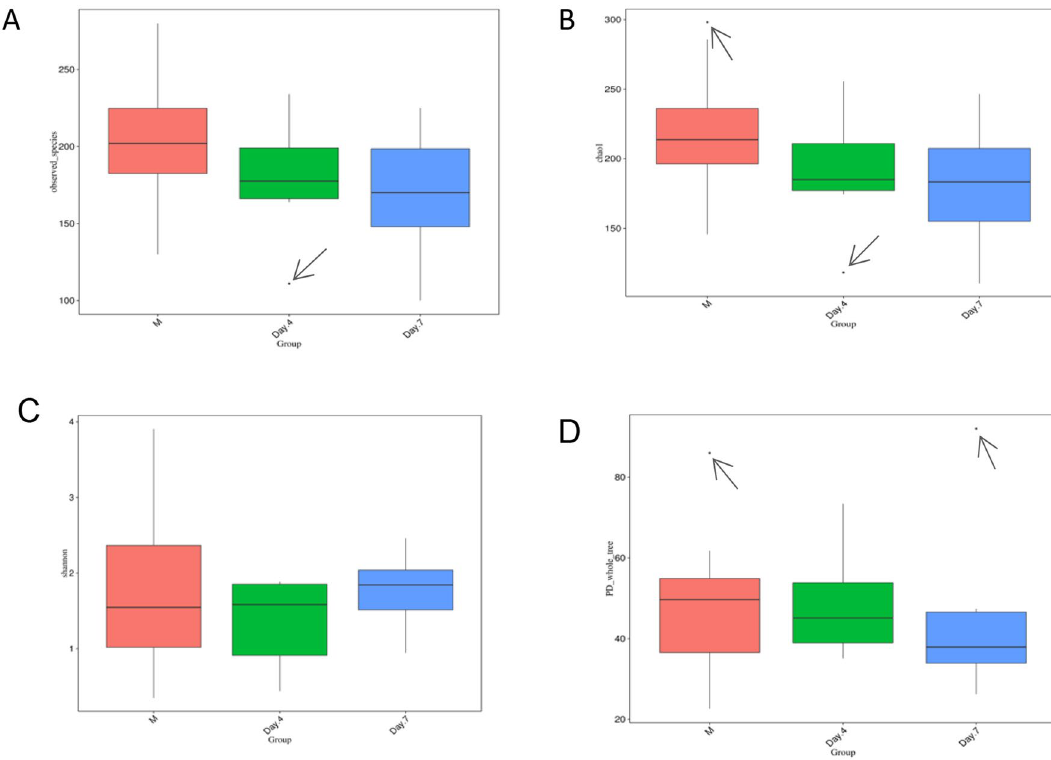
Figure 2. Differences in alpha diversity indices among groups shown by a boxplot. ( A ) Observed species, ( B ) Shannon index, ( C ) Chao1 index, and ( D ) Faith’s phylogenetic diversity across three time points. Boxes represent the interquartile ranges (IQRs) among M, Day 4, and Day 7, while the horizontal lines inside the boxes define the medians. Whiskers represent the lowest and highest values within 1.5 times the IQR. Small circle symbols in ( A ), ( C ), and ( D ) indicate outliers (values greater than 1.5 times and less than three times the IQR). Generated by using R Software 24